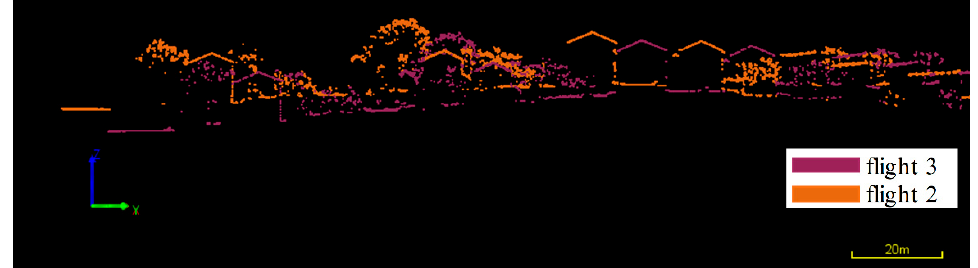
Figure 22. Vertical section of point cloud in opposing flight strips (flight 2 and flight 3) without installation angle compensation.